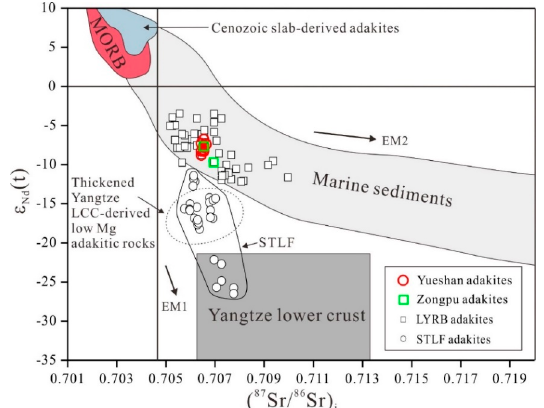
Figure 13. Initial Sr-Nd isotopes of the Yueshan and Zongpu adakites from the Anqing orefield (data sourced from [28,32,69]; diagram modified after from [30]). Data sources: Cenozoic slab-derived adakites [70], thickened Yangtze lower crust-derived low-Mg adakitic rocks [71–73], LYRB and STLF (South Tan-Lu Fault) adakites [28,30], and the early Cretaceous mafic igneous rocks in the LYRB [74]; MORB and marine sediments [75]; Yangtze lower crust [76].